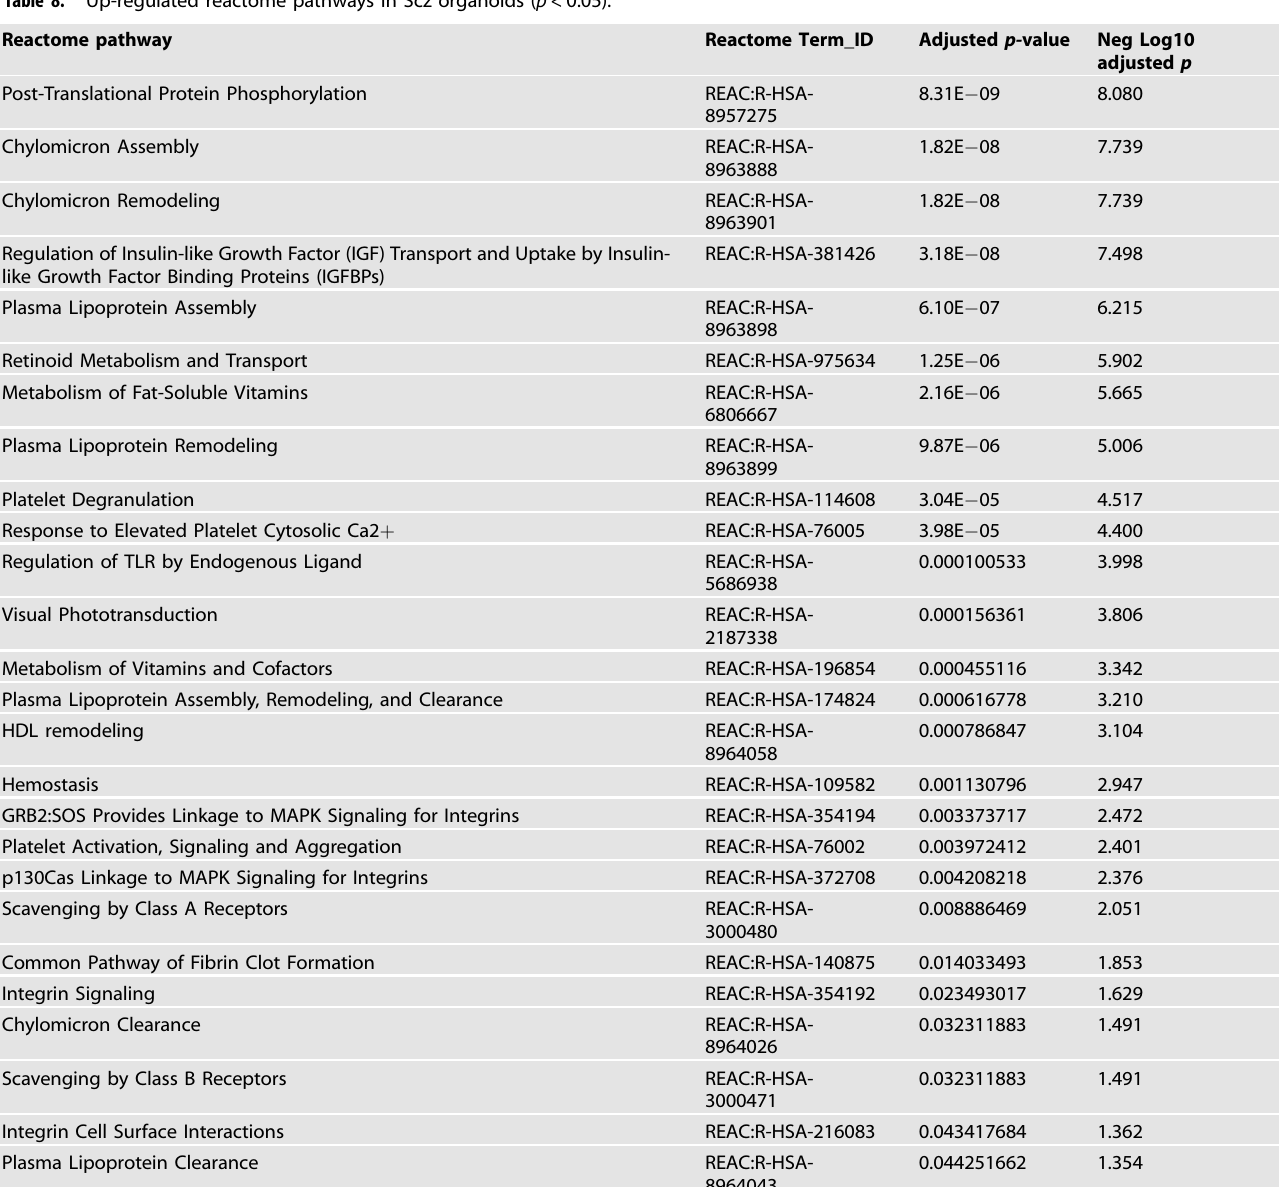
Table 8. Up-regulated reactome pathways in Scz organoids ( p <